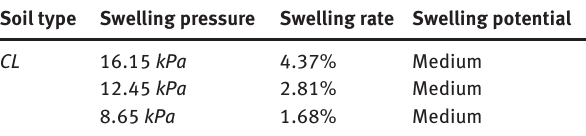
Table 2: Swelling rate and swelling